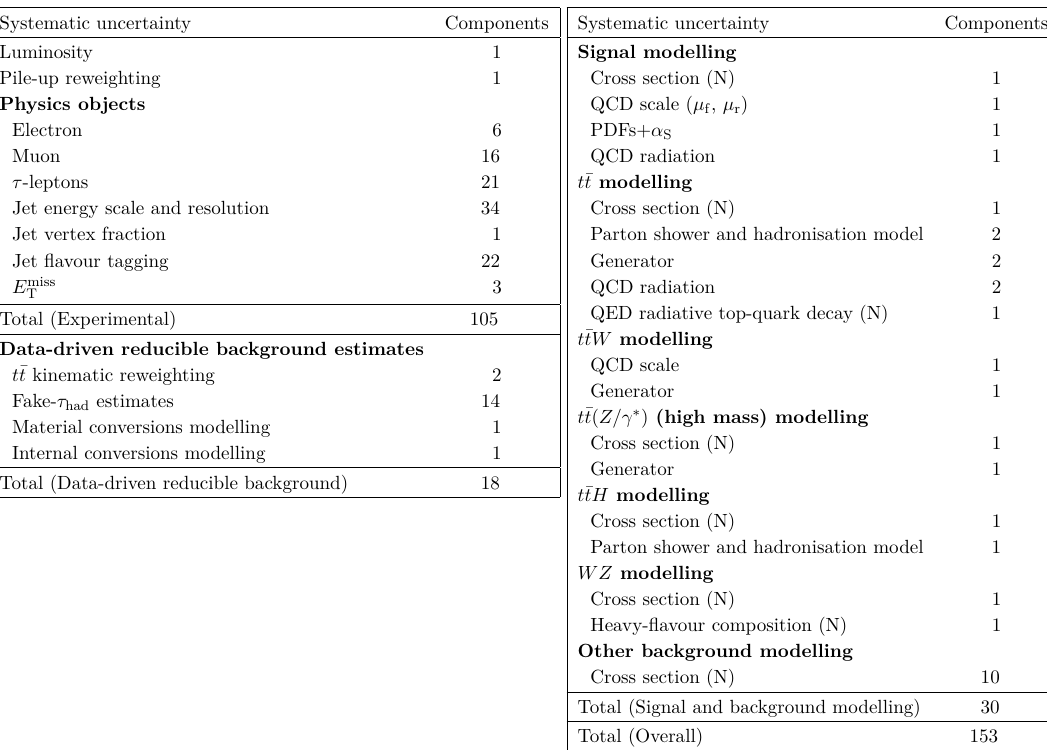
Table 9. Sources of systematic uncertainty considered in the analysis. “N” means that the uncertainty is taken as normalisation-only for all processes and channels affected. Some of the systematic uncertainties are split into several components, as indicated by the number in the rightmost